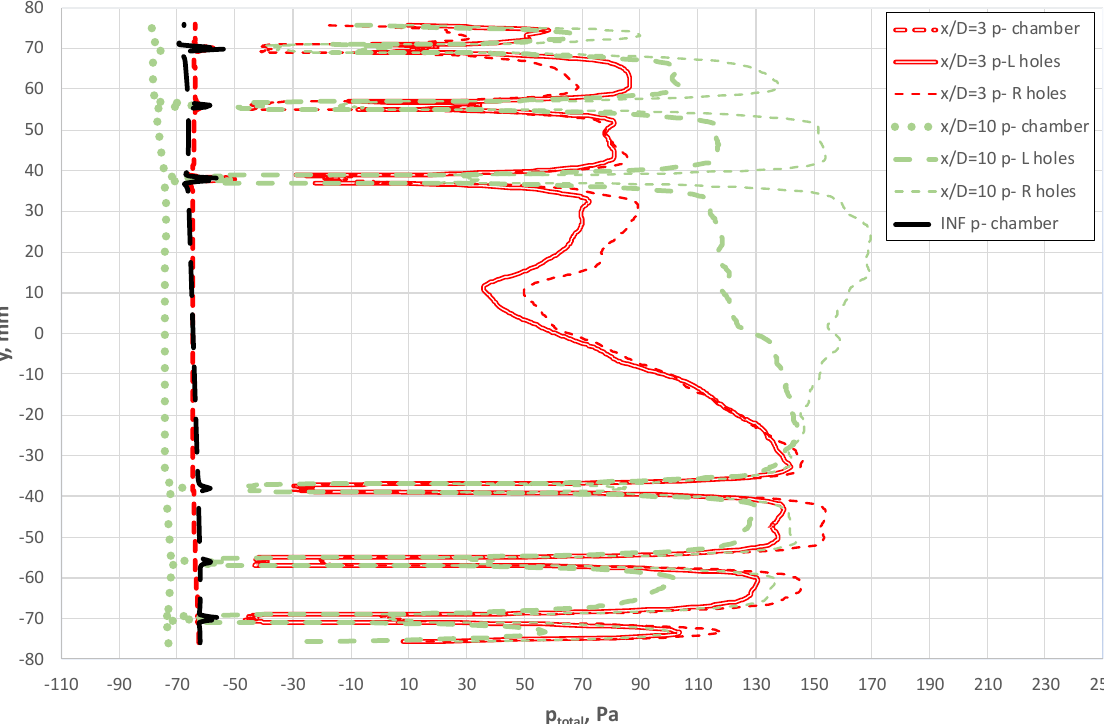
Figure 16. Total pressure along the axis of the p − chamber and along the lines combining the p − hole on the external probe surface.